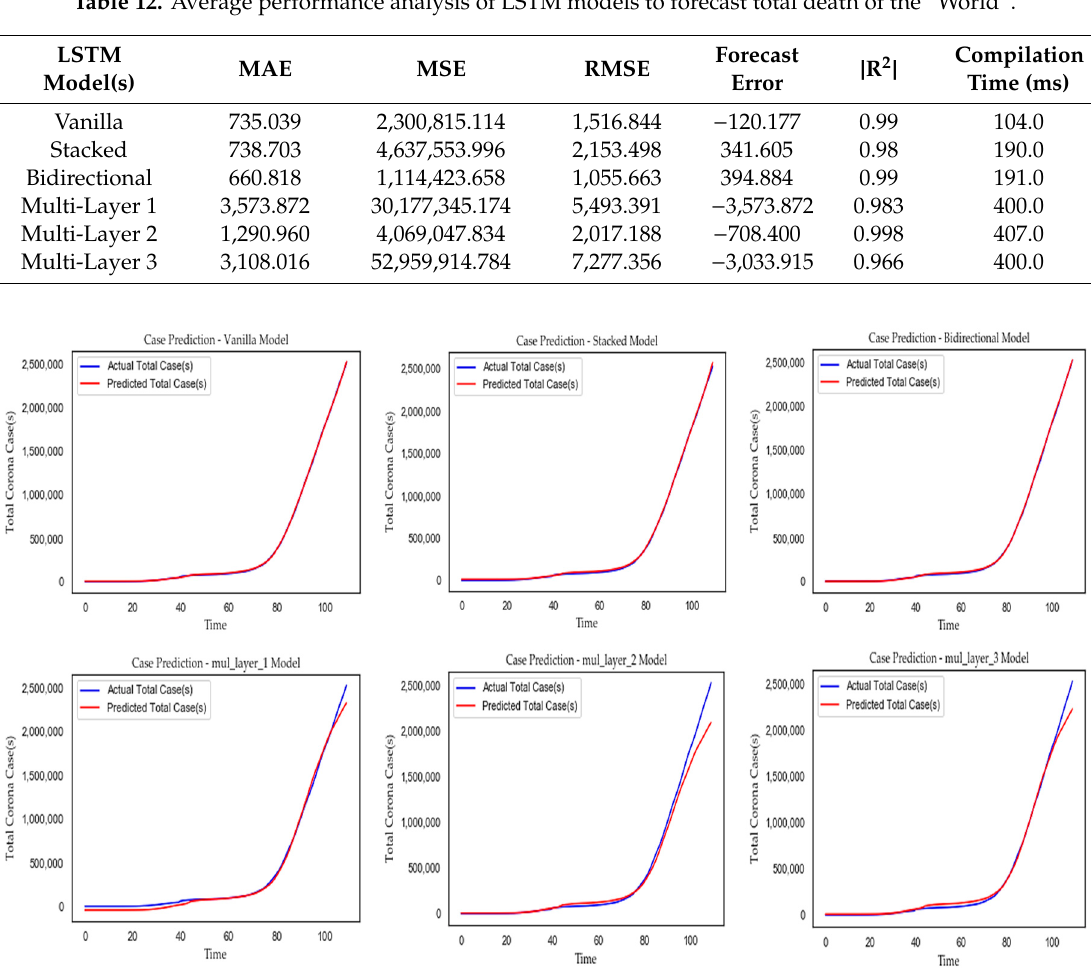
Figure 11. Comparing the calibration of the LSTM models to forecast total deaths of the “World”. 5. Conclusions The statistical correlation study proved that COVID-19 does not depend on external weather factors, such as external temperature, sunshine, and precipitation. It depends on the population and its density mostly. Therefore, it is considered as a community disease. This research verified our assumed hypothesis that social isolation/social distancing might restrict the spreading of the human coronavirus by diminishing its spread factor. The forecasting of probable new corona cases and death